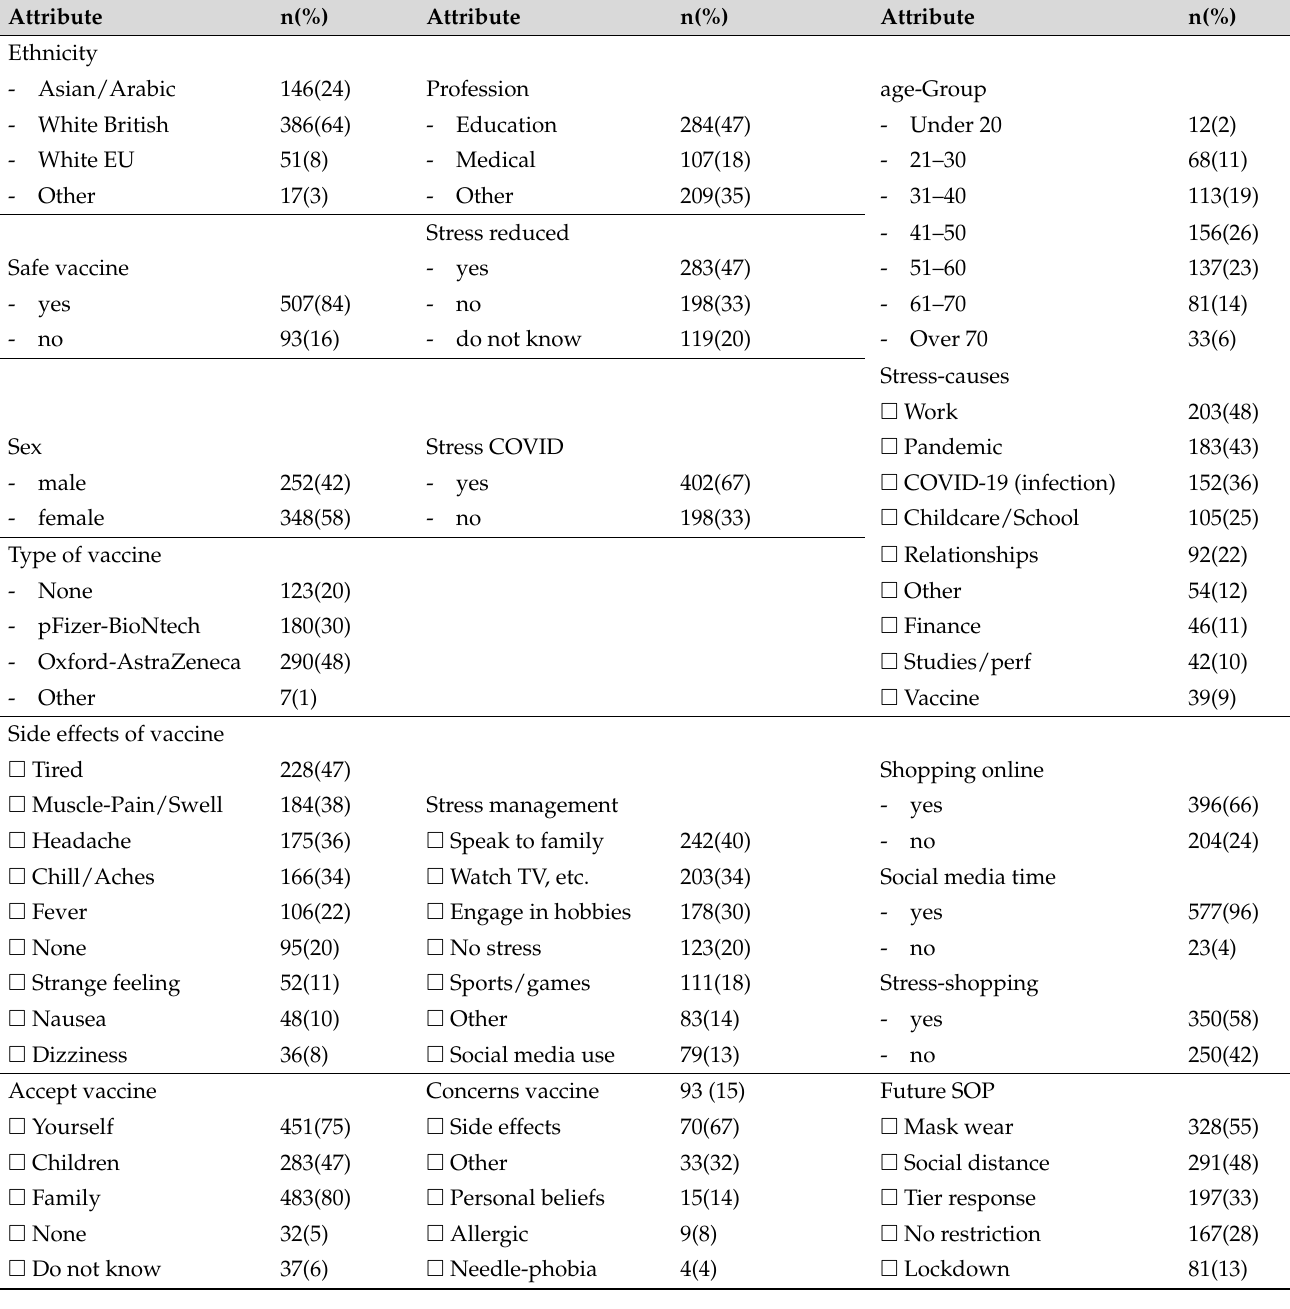
Table 2. Distribution of public responses (i.e., attributes) to outlined survey questions. Detailed visualisations of attribute distributions are presented in Supplementary